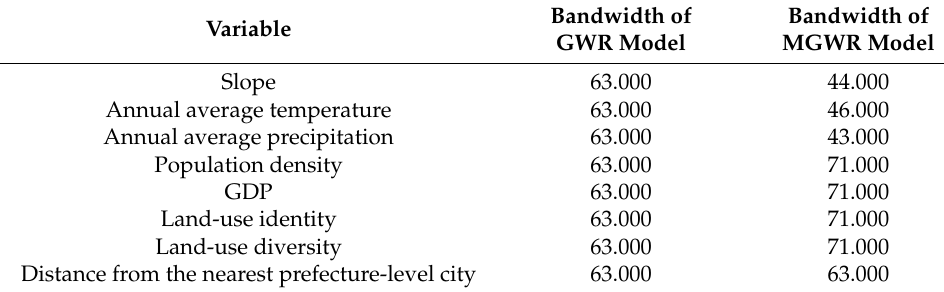
Table 8. Variable bandwidth for GWR and MGWR